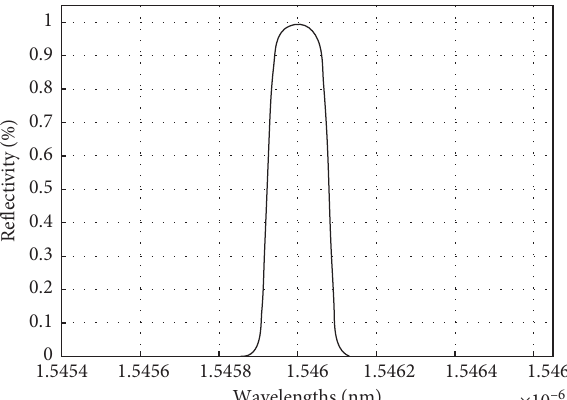
Figure 12: Reflectivity of one optical channel.